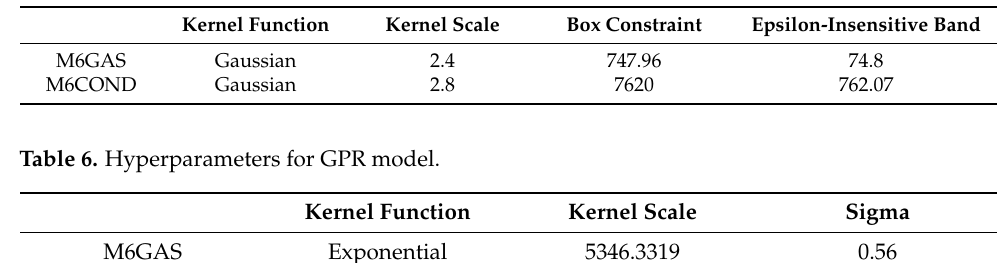
Table 5. Hyperparameters for SVR model.